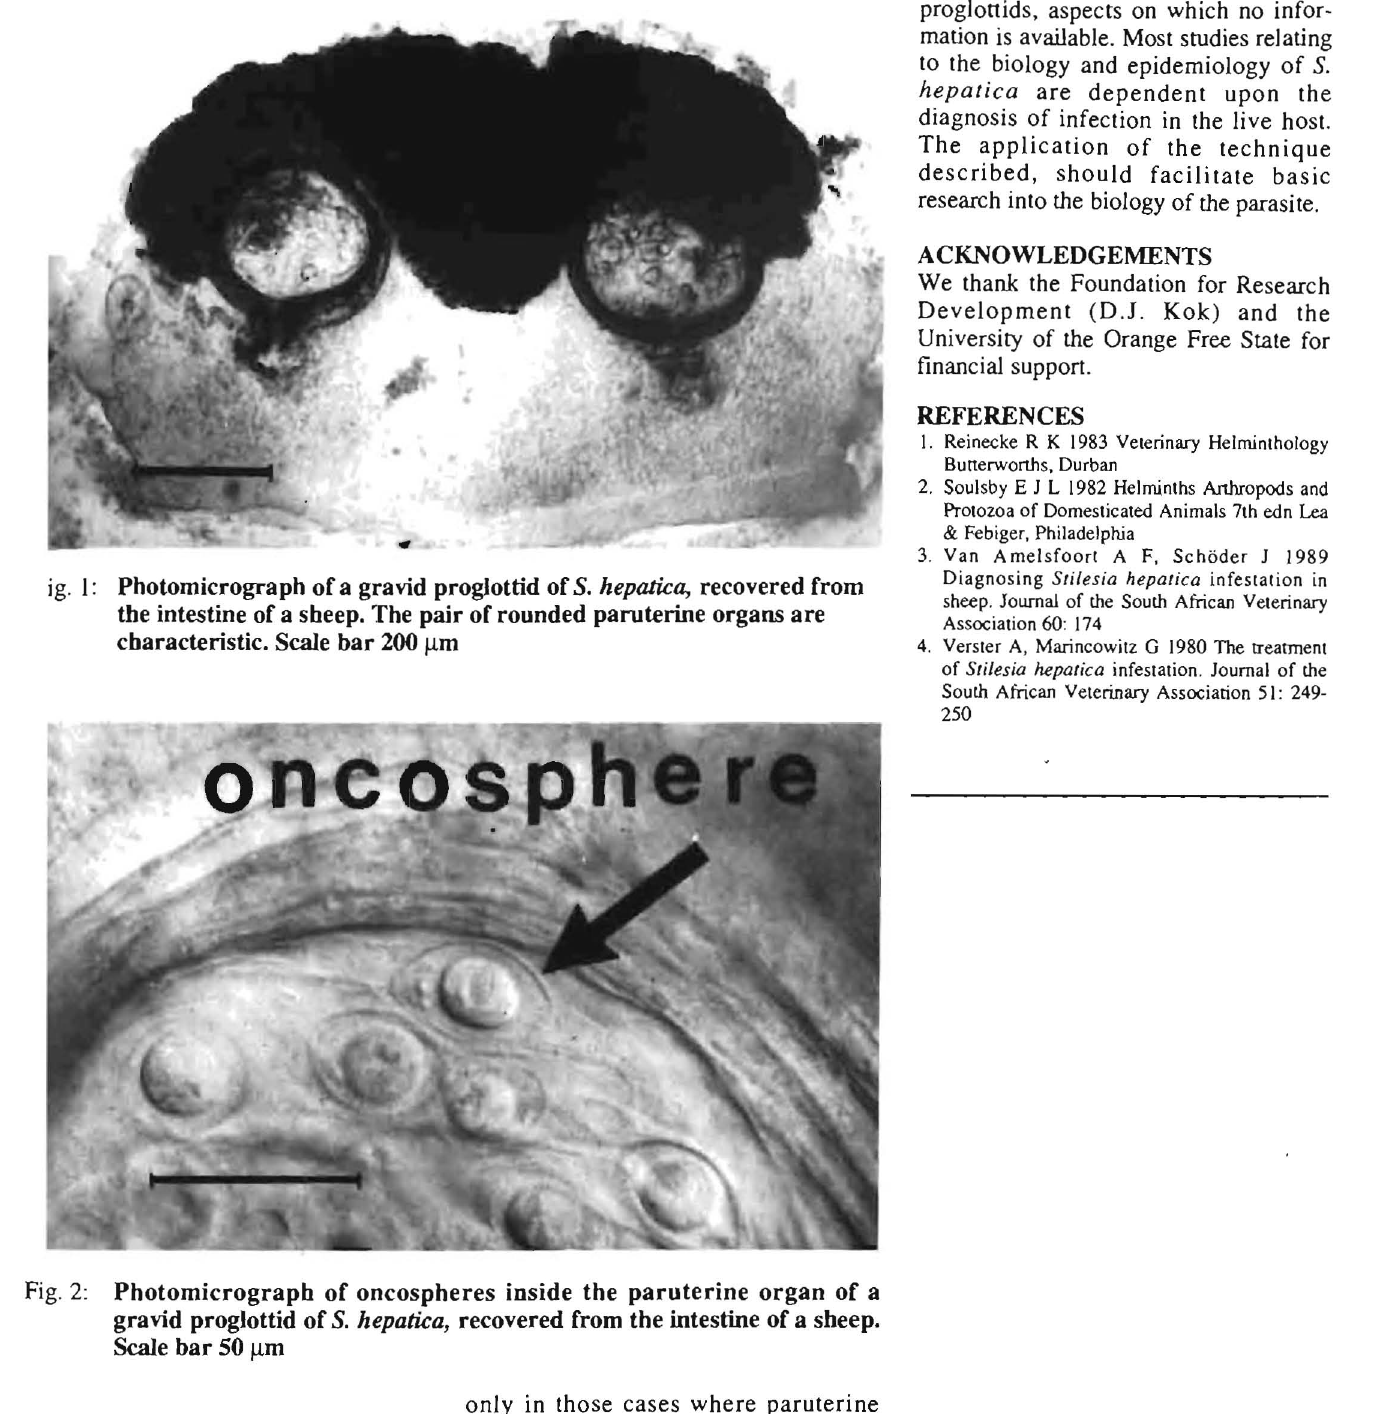
Fig. 2: Photomicrograph of oncospheres inside the paruterine organ of a gravid proglottid of S. hepatica, recovered from the intestine of a sheep. Scale bar 50 ~m